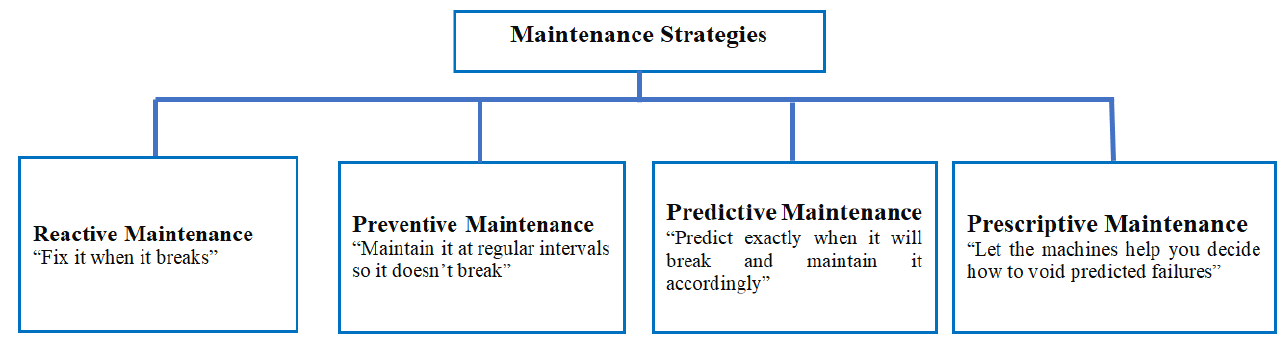
Figure 1. Maintenance strategies.